Question: Produce a descriptive caption suitable for publication.
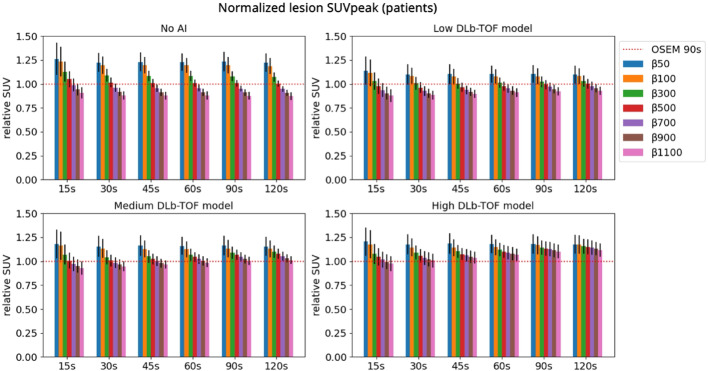
Answer: Lesion SUV peak value normalized to SUV peak of OSEM 90 s, as a function of acquisition time and β-value without (No AI) and with the three levels of DLb-TOF model (Low, Medium and High). The dotted line represents normalized SUV peak for 90 s acquisition time reconstructed with OSEM. Error bars indicate ± 1 SD